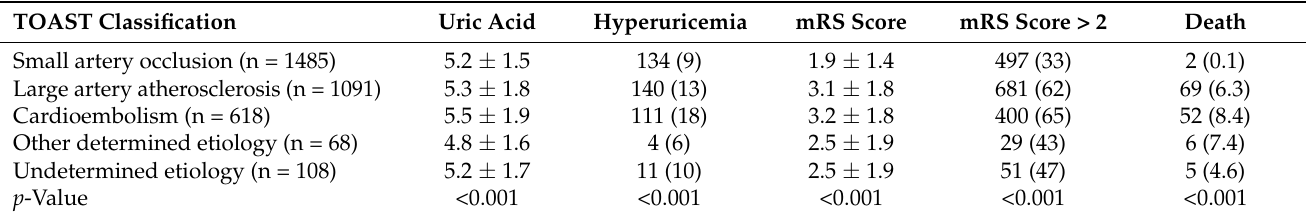
Table 4. Distributions of serum uric acid levels and outcomes by TOAST classification in 3370 patients with acute ischemic